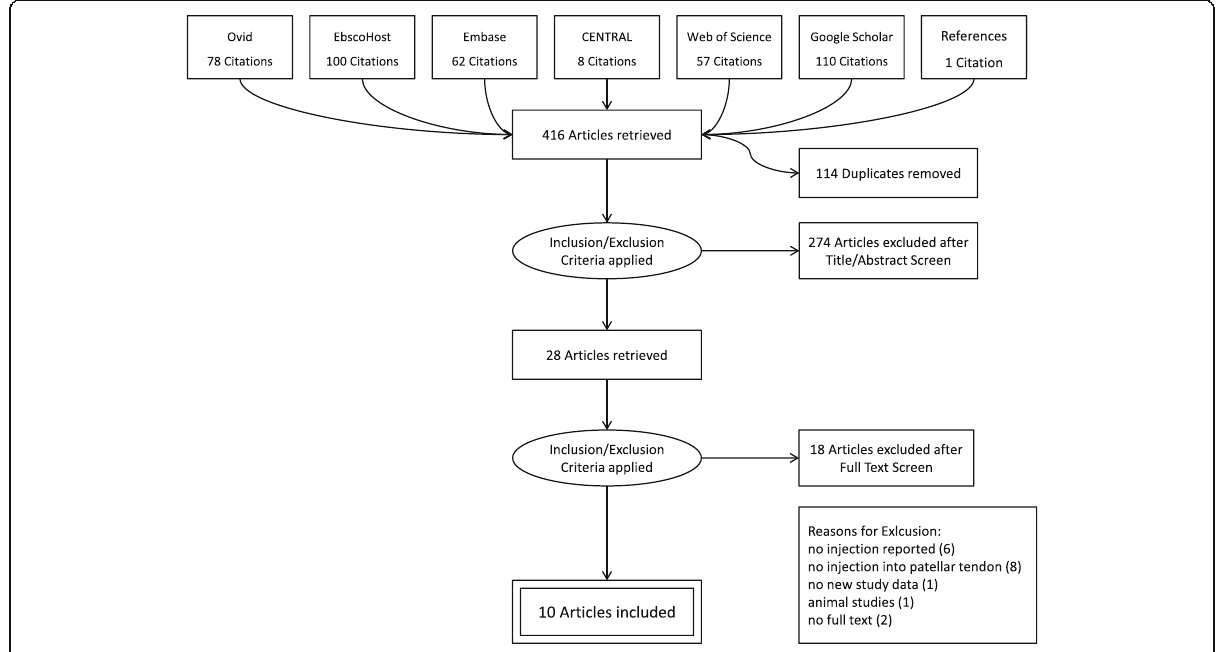
Fig. 1 Flowchart of the selection process according to PRISMA